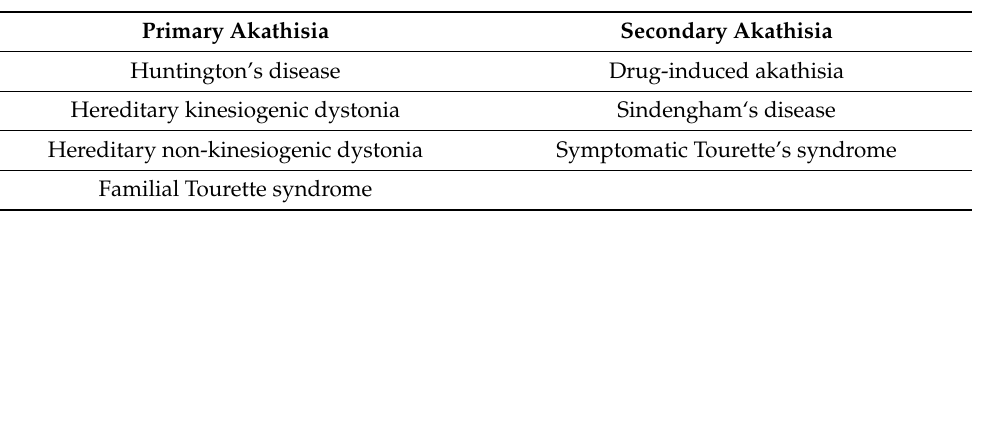
Table A1. Primary and secondary